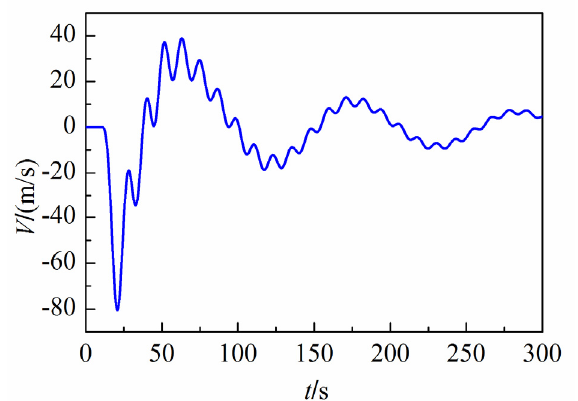
Figure 35. Gas pressure in the surge tank for Case 1.